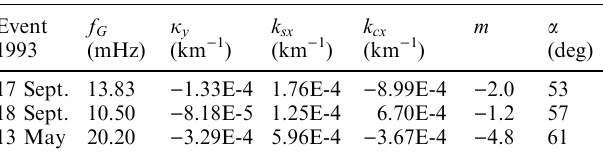
Table 2. Estimated dynamical characteristics of both the wave c - and s -modes on Freja and the ground-signal weighted frequency f G : coordinate components of the wave vectors, azimuthal wave number m and the deflection angle (cid:97) of the s -wave front (positive to the